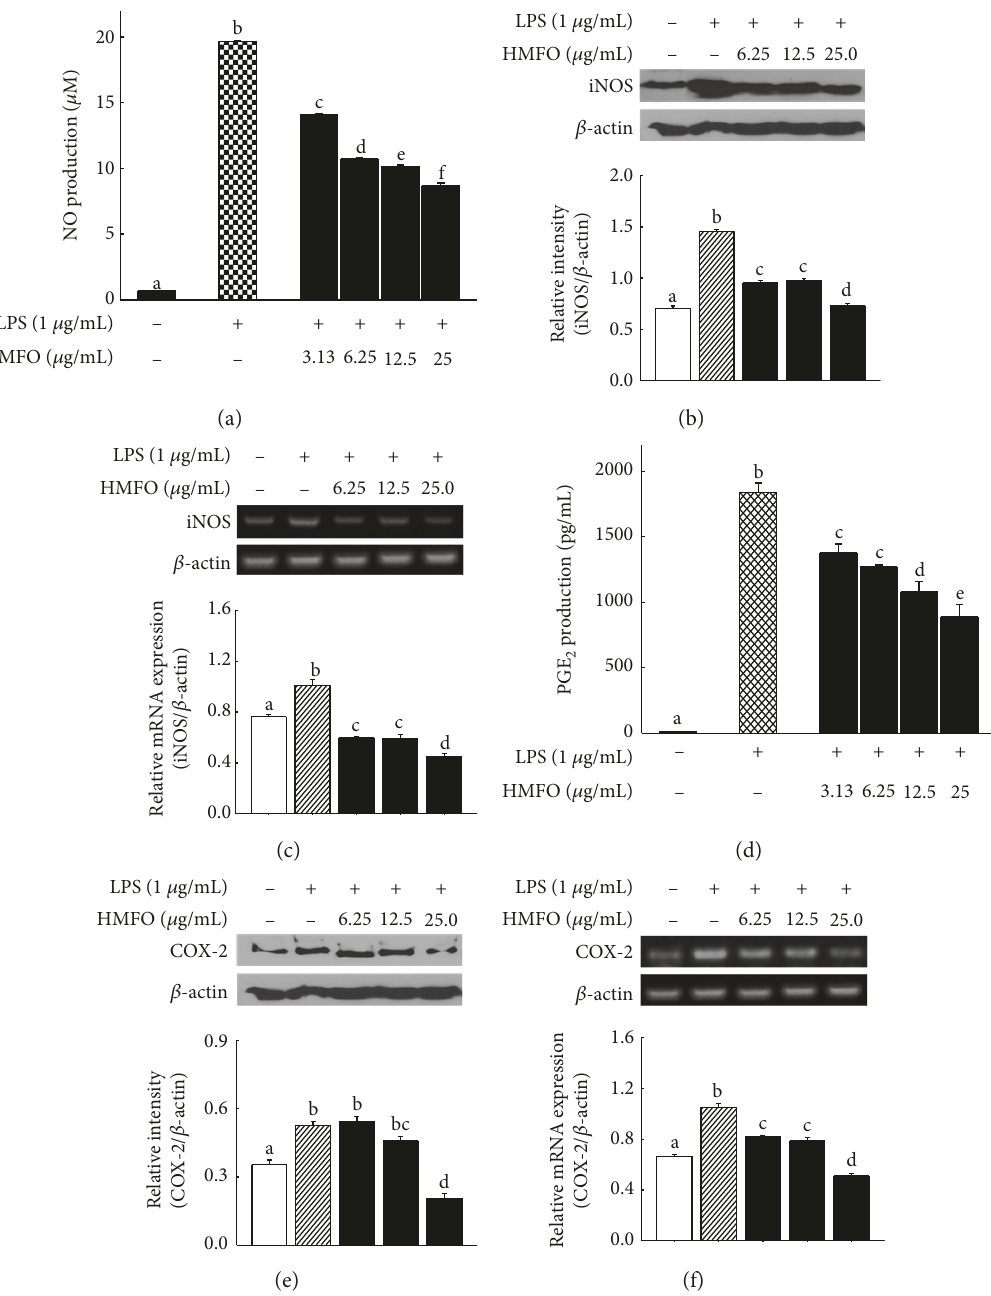
Figure 5: HMFO inhibited LPS-induced in fl ammatory mediators by suppressing iNOS and COX-2 activation in RAW 264.7 macrophages. RAW 264.7 macrophages were pretreated with di ff erent HMFO concentrations for 2 h and then stimulated with LPS (1 μ g/mL) for 22 h. (a) Supernatant NO concentrations were calculated by comparing the measured values to those of standard concentrations of sodium nitrite dissolved in DMEM. (b, e) Cell lysates were obtained, and iNOS and COX-2 protein levels were analyzed by Western blotting. (c, f) Total RNA was isolated, and iNOS and COX-2 mRNA levels were measured by RT-PCR. (d) PGE was quanti fi ed using an ELISA kit according 2 to the manufacturer ’ s protocol. Values with di ff erent letters are signi fi cantly di ff erent ( p < 0 05